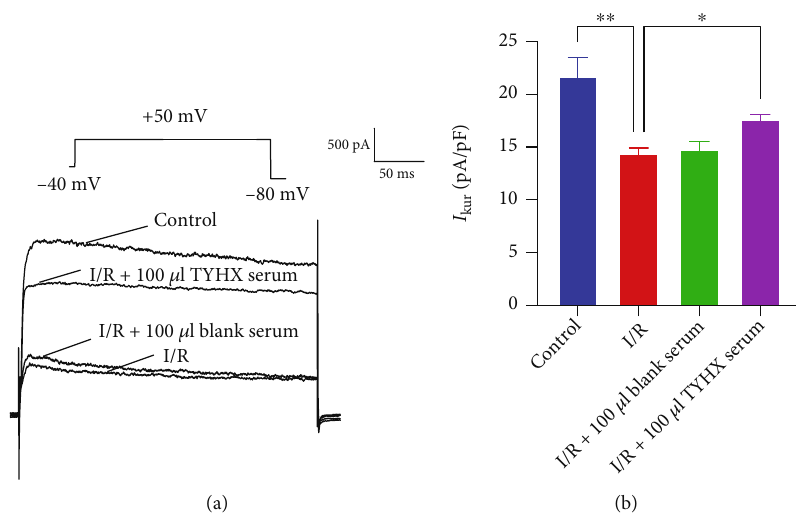
Figure 5: The e ff ect of TYHX on the peak current of I